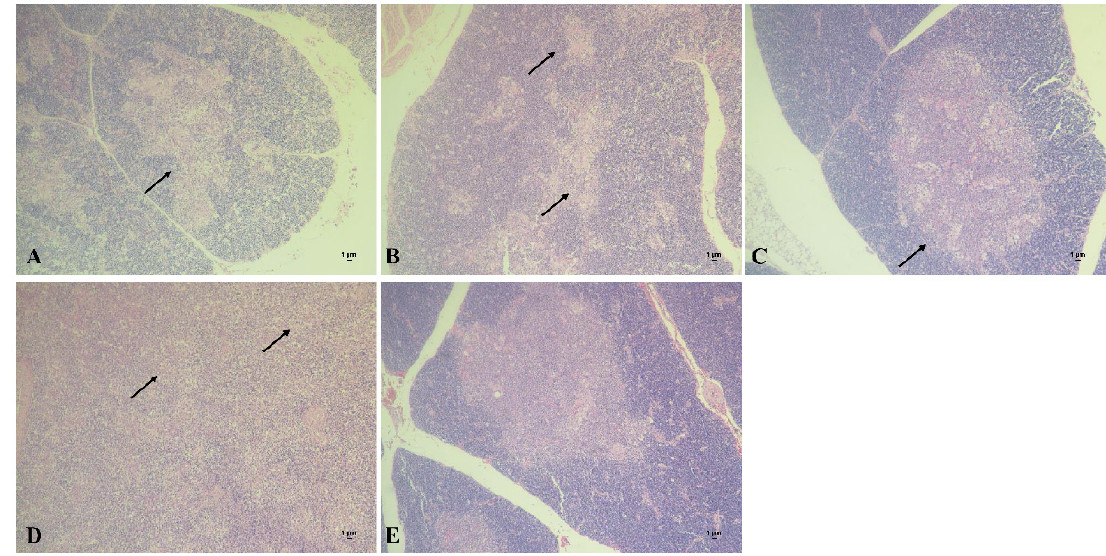
Figure 6. Section observation of chicken thymuses in different groups after CIAV challenge. ( A ): Chicken thymus of DNA vaccine group (100×). ( B ): Chicken thymus of subunit vaccine group (100×). ( C ): Chicken thymus of combined vaccine group (100×). ( D ): Chicken thymus of CIAV infection control group (100×). ( E ): Chicken thymus of blank control group (100×).